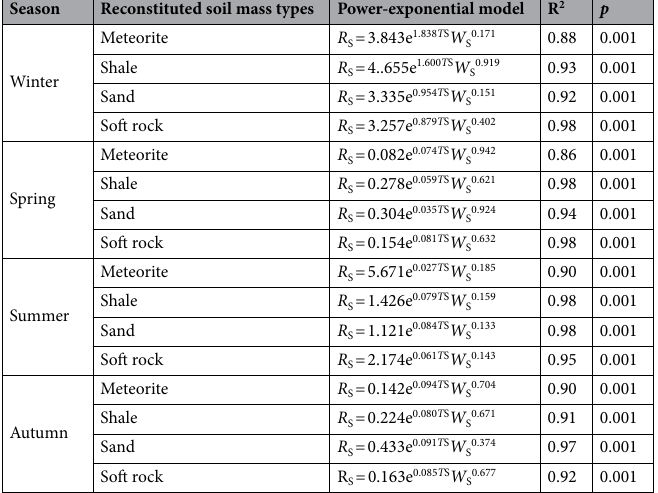
Table 4. Relationship between soil respiration rate and hydrothermal factors for reconstituted